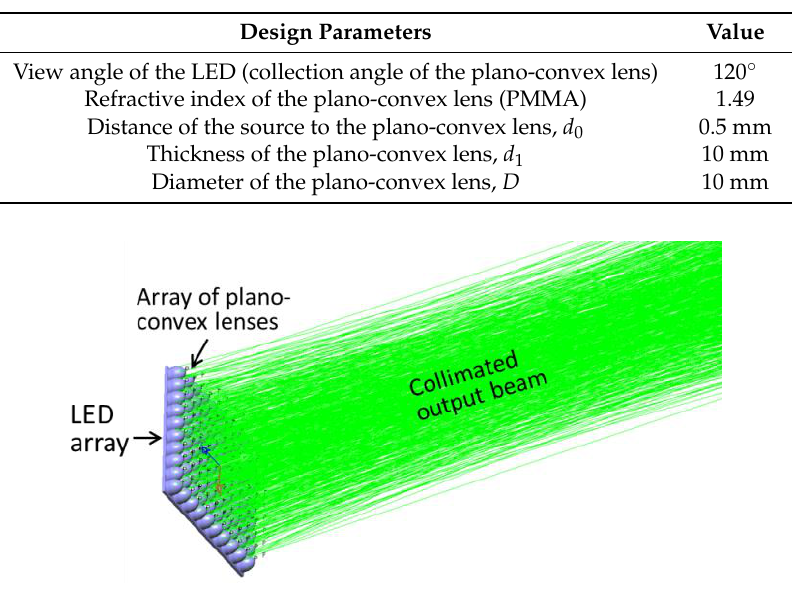
Figure 5. An array of plano-convex lenses is placed on top of the LED array to collimate the LED light.